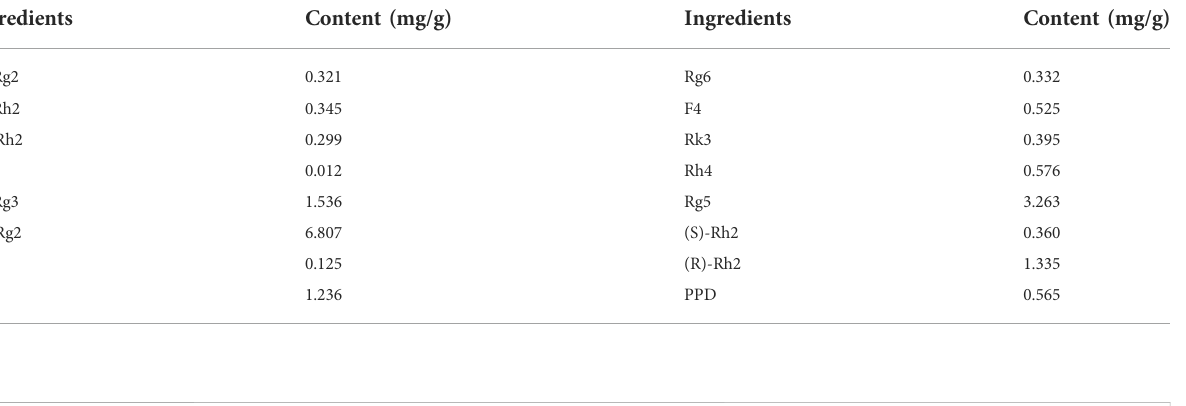
TABLE 2 Content of ginsenosides in FGP.